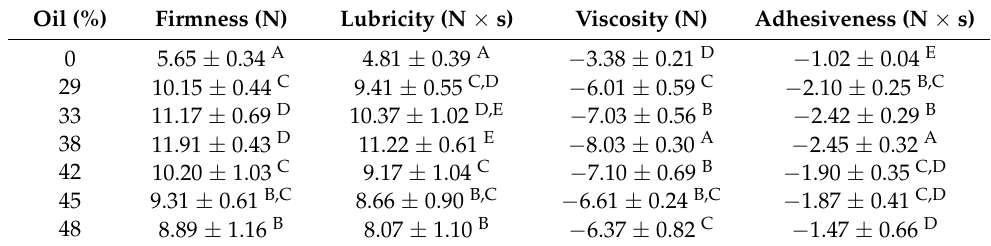
Table 1. Effect of oil concentration on the hydrogel texture parameters.